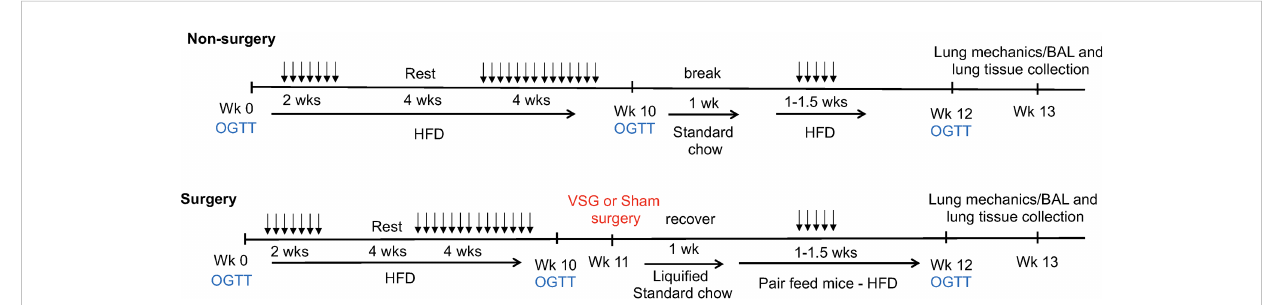
FIGURE 1 Schematic depiction of experimental time course. 5-week-old mice underwent oral glucose tolerance testing (OGTT) on weeks (Wk) 0, 10 and 12. 50 m g of house dust mite extract or saline (vehicle control) was delivered via intranasal administration in 40 m Ls saline 3 times per week (doses shown as arrows) for the durations shown. High fat diet (HFD – 60% kcal fat) or standard chow diet (13% kcal fat) was given ad libitum for the durations shown. Vertical sleeve gastrectomy (VSG) or Sham surgeries were performed at week 11. Mice were pair fed after surgery. Lung mechanics measurements as well as bronchoalveolar lavage (BAL) and tissue collection in mice occurred at week